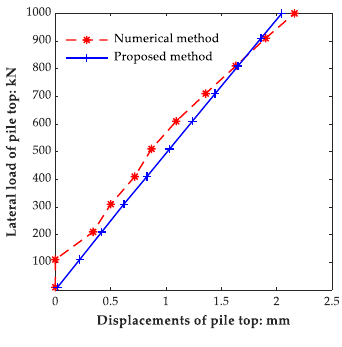
Figure 13. p – y curve of pile top.